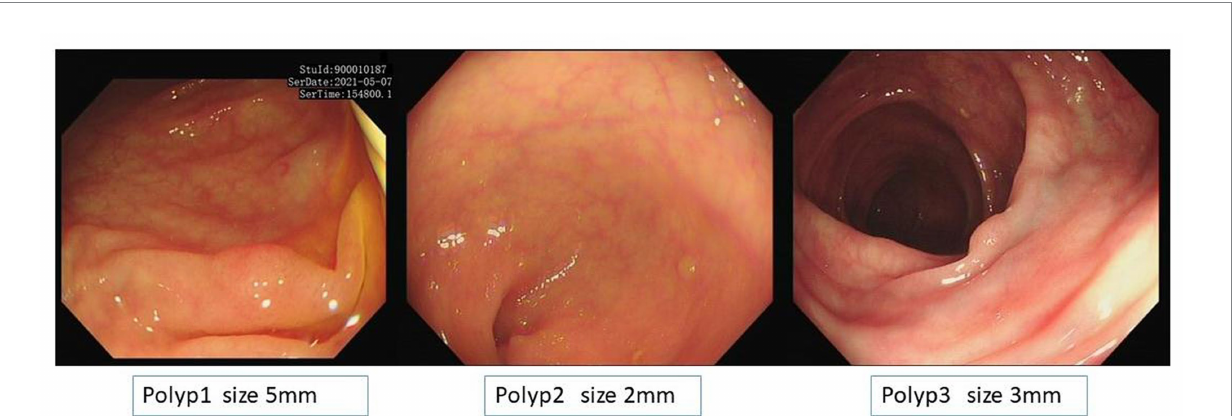
FIGURE 2 Images of the three unsuccessful recognition polyps and polyp 1 is the unsuccessful false-negative polyp when it was calculated based on image